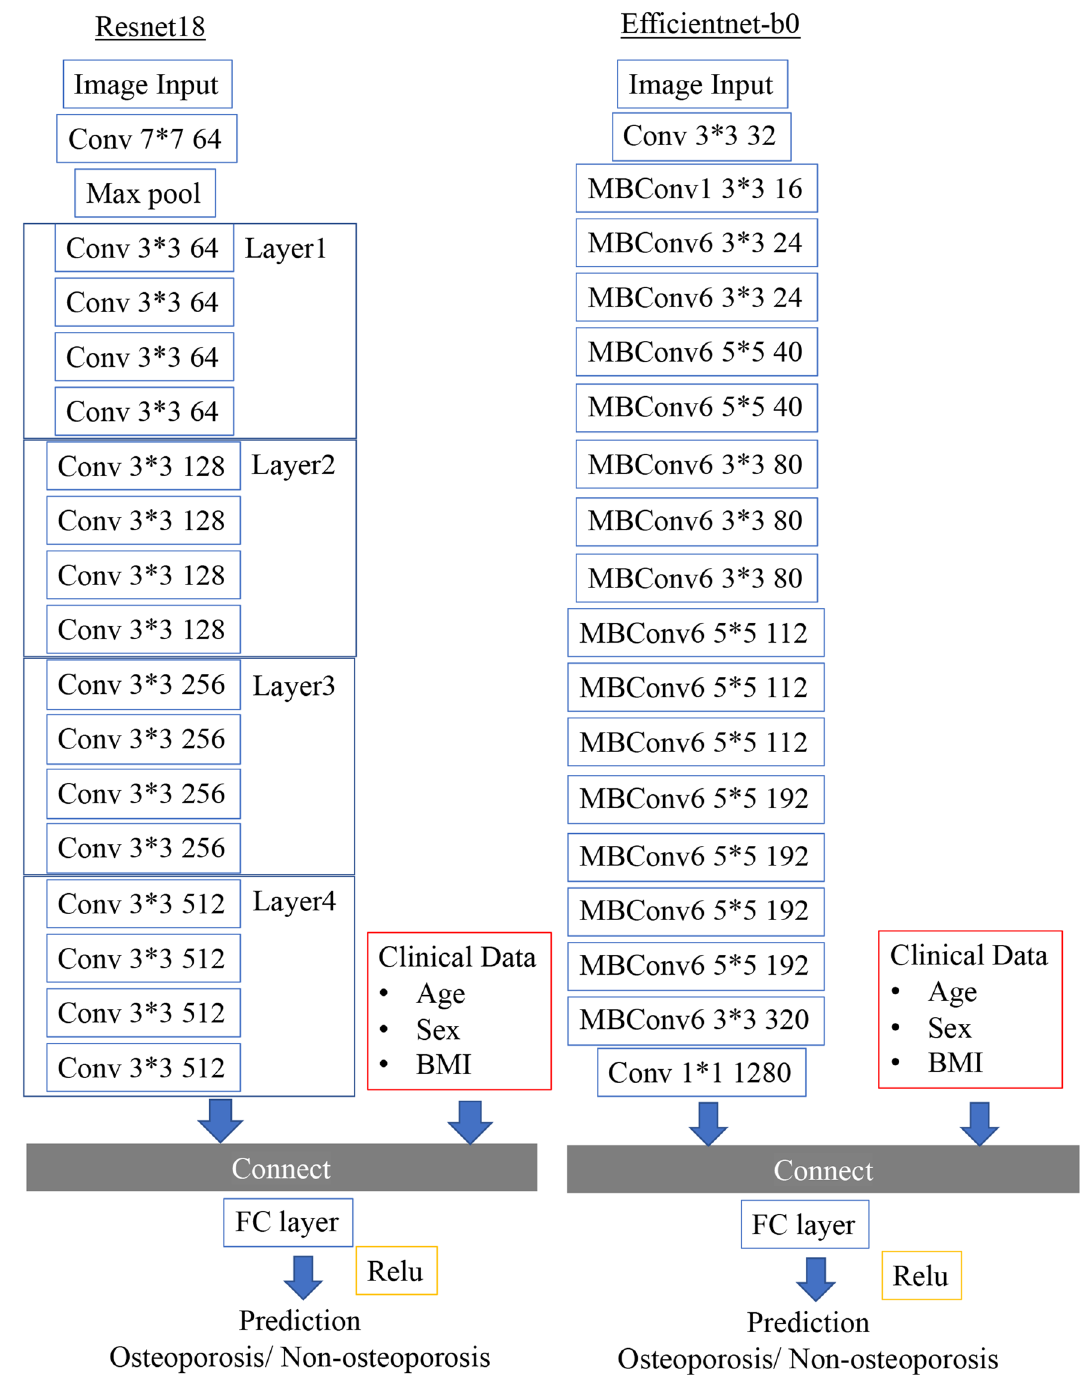
Figure 3. Neural network architecture that ensembles image data and clinical covariates. As representative models, ResNet18 and EfficientNet-B0 models are